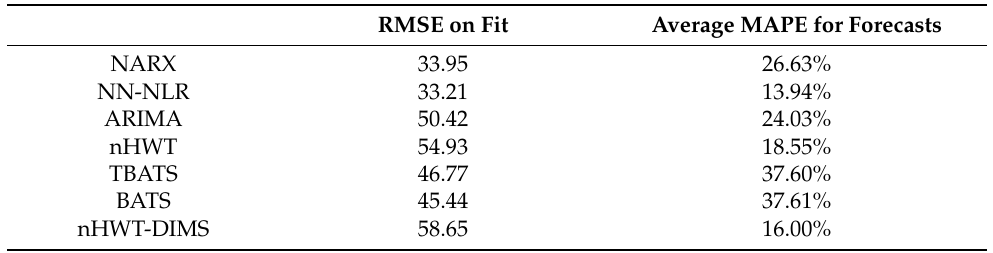
Table 5. Main benchmarking results. RMSE used to compare fitted results. MAPE used to compare forecasts